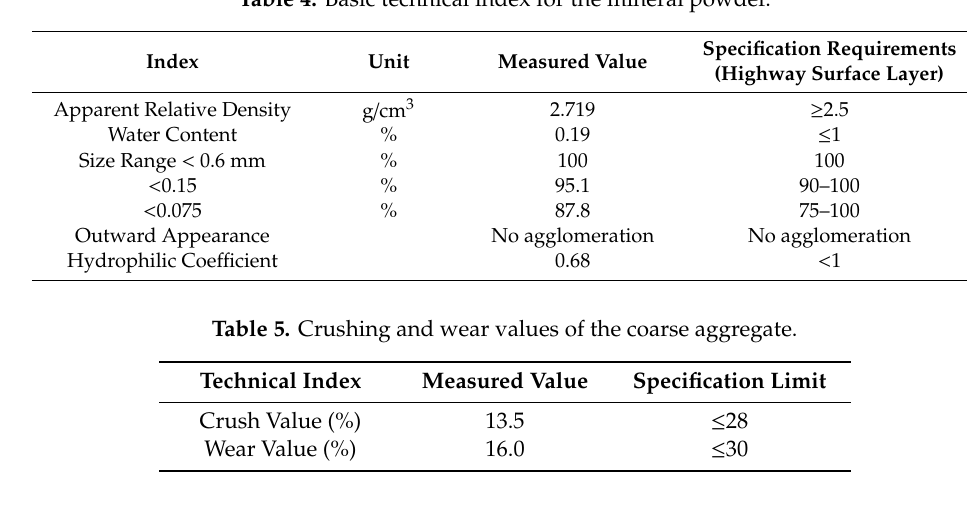
Table 4. Basic technical index for the mineral powder.